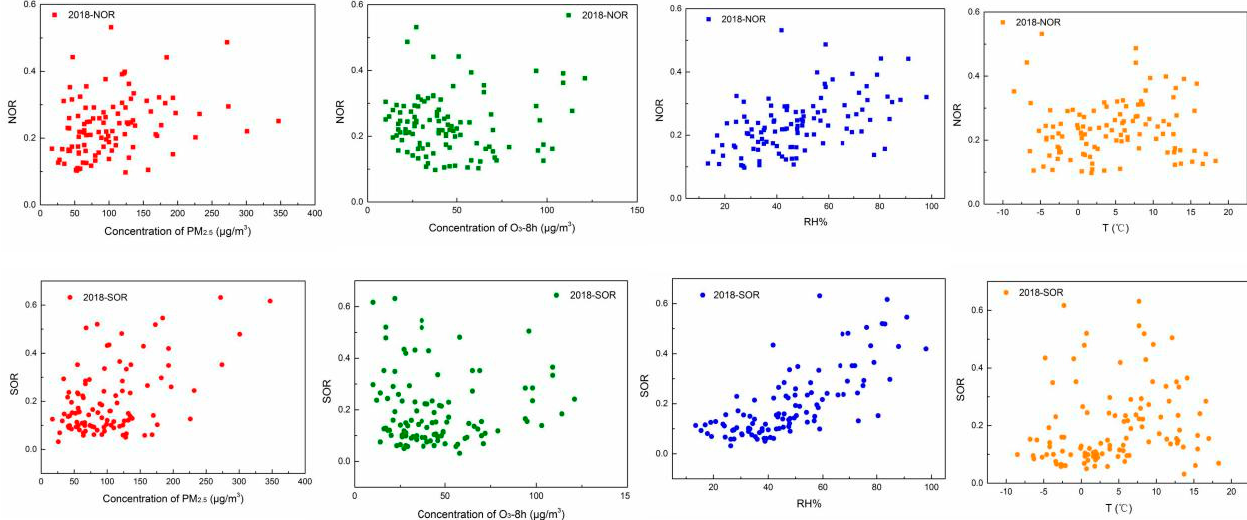
Figure 8. Correlations of SOR and NOR against PM 2.5 and O 3 concentration, relative humidity, and temperature in the autumn–winter season of 2018–2019. Table 4. Kendall’s tau coefficient between NOR, SOR, and the temperature, relative humidity con- centration of PM 2.5 , O 3.